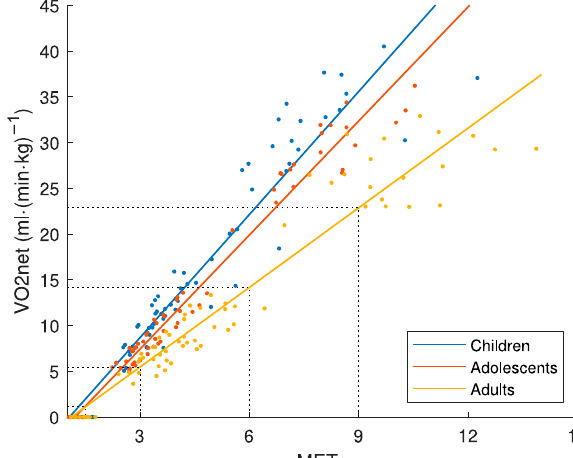
Figure 4. Definition of the common VO 2net cut-points representing light PA (LPA), moderate PA (MPA), vigorous PA (VPA) and very vigorous PA (VVPA) based on adult MET values, in children 9–11, adolescents 14–16 and adults 23–44 years old.